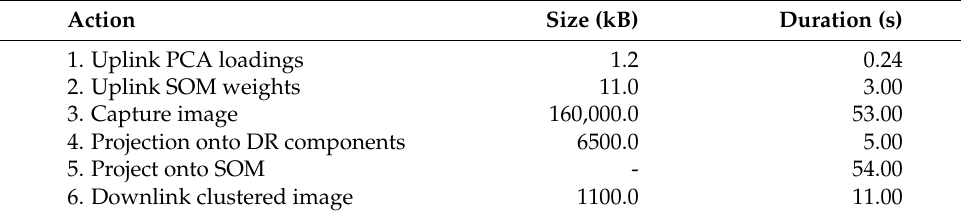
Table 3. The single-stage procedure for data